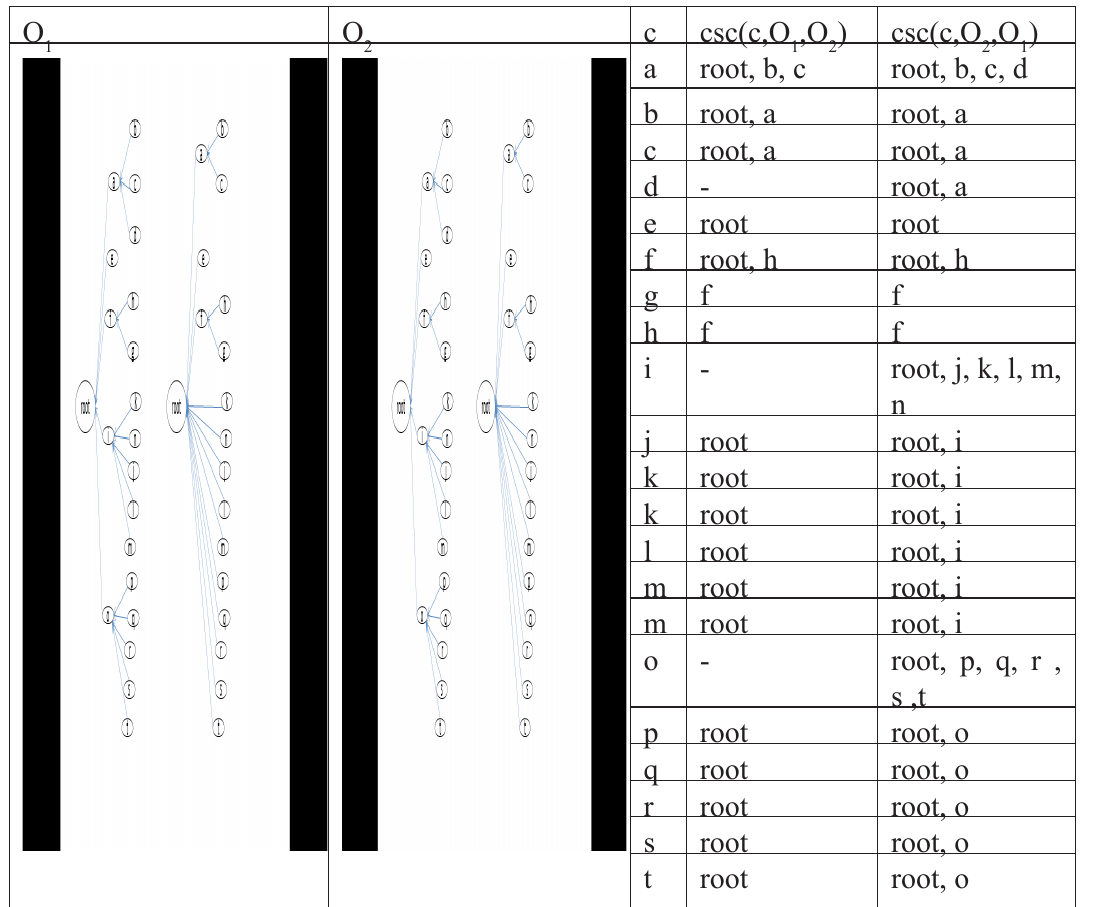
Comparison of the Learned Ontology and Reference